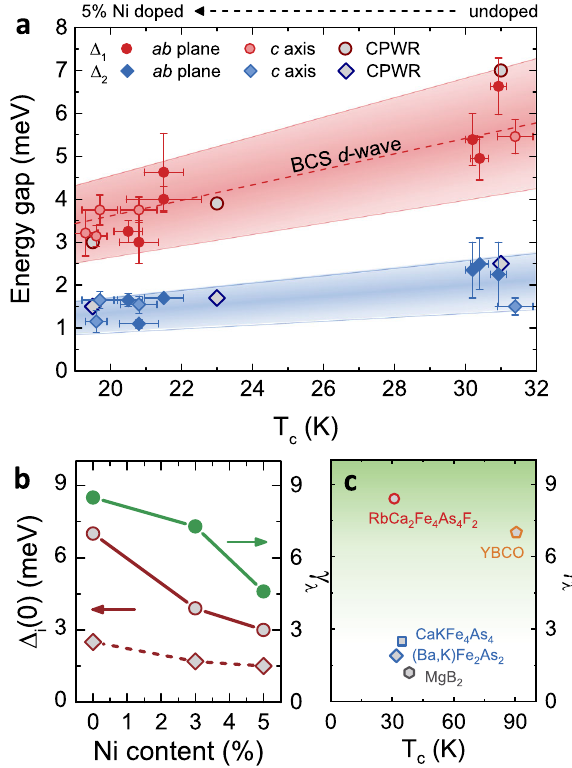
Fig. 4 Gap values and anisotropy of Rb-12442. a Amplitude of the SC energy gaps extracted from the fi t of PCARS spectra using the d − d model as a function of the Andreev T c , and from the d − d wave BCS fi t of the super fl uid density. Error bars represent the interval of gap values obtained with different normalizations of the same curve, and include the uncertainty arising from the fi t. The colored regions are bound by lines with constant gap ratio 2 Δ / k B T c . The dashed line is the gap amplitude expected for a BCS, single-gap, d -wave superconductor. b Ni-doping dependence of γ λ at 6 K (right scale) and of the SC energy gap values extracted from the BCS fi ts in Fig. 3 (left scale). c Anisotropy of the London penetration depth (measured at T ≃ 5 – 6 K) in the undoped Rb-12442 single crystal compared to that of MgB 258 , other IBSs of the generalized 122 family 46,59 , and YBCO 49